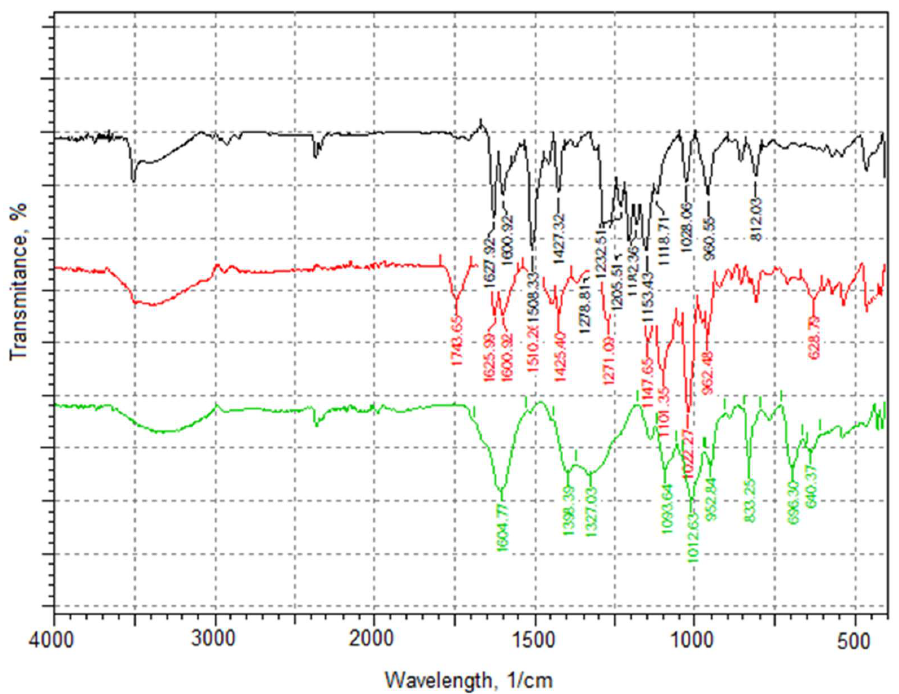
Figure 7. Infrared (IR) spectra: curcumin powder (black), pectin aerogel loaded with curcumin (red), and chitosan-coated pectin aerogel loaded with curcumin (green).